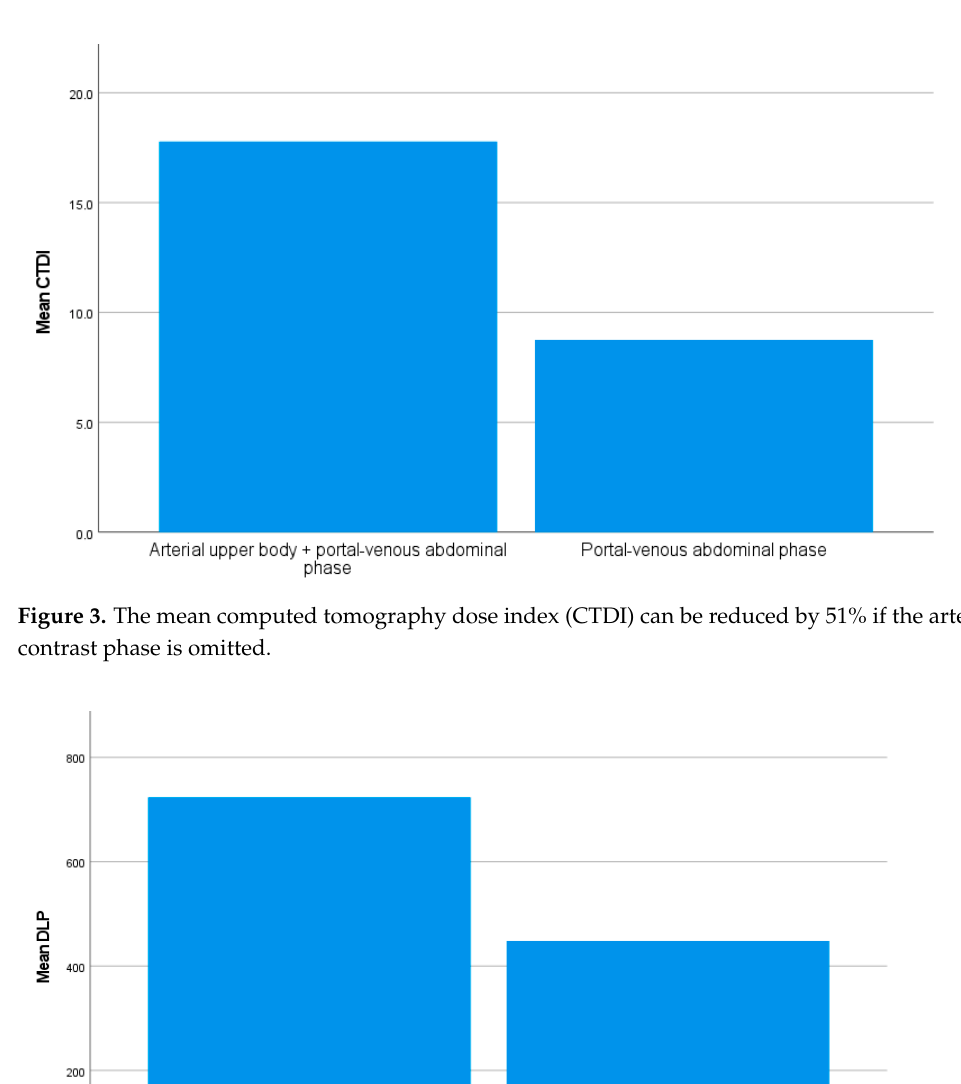
SD: standard deviation.